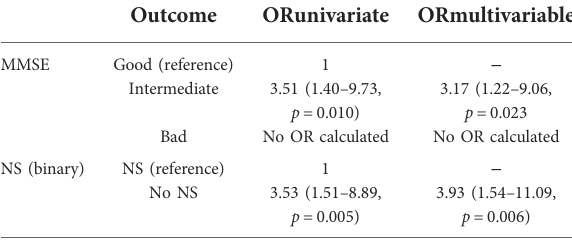
TABLE 4 Univariate and multivariable logistic regression regarding ePPI, one day after catheter removal (8). Outcome ORunivariate